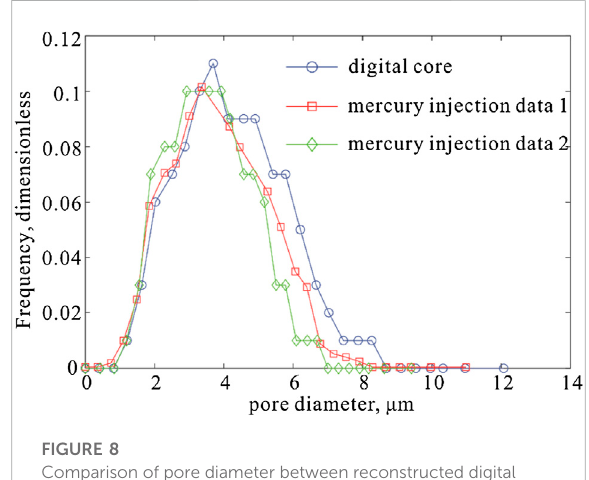
FIGURE 8 Comparison of pore diameter between reconstructed digital core and mercury injection